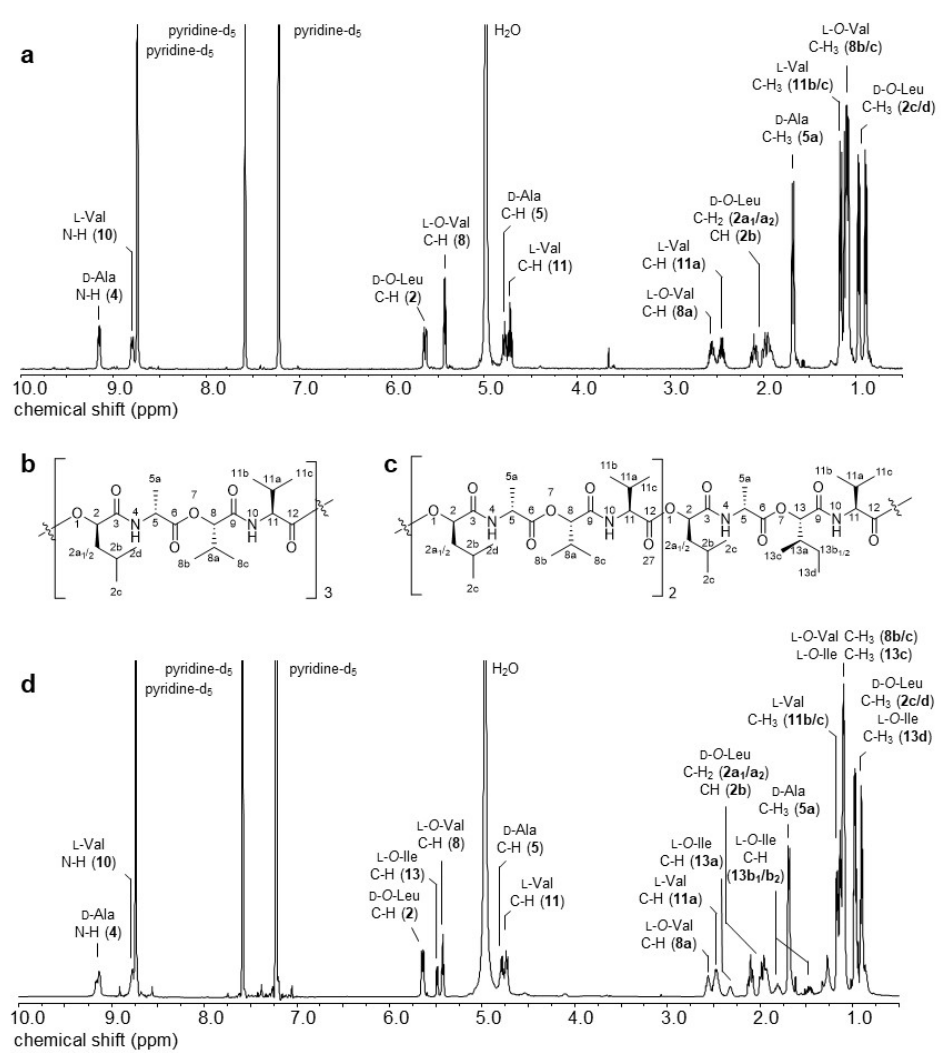
Figure 1. 1 H-NMR spectra and corresponding chemical structures of ( a , b ) cereulide ( 1 ) and ( c , d ) isocereulide A ( 2 ). From the further generated 1 H- 1 H-COSY-spectrum (Figure 2), the correlation of the single proton signals could be observed, giving, in combination with the signals integrals, the structures of the single amino acids Ala and Val ( × 3 each) and α -hydroxy acids O -Leu ( × 3) and O -Val ( × 2), but revealing one additional O -Ile moiety. This can be deducted from the correlation of the signals shown in Figure 2, with the key signal being the methine group 13a, exhibiting a correlation to the methyl protons 13c as well as to the methylene protons 13b 1 /b 2 . Those novel NMR experiments shed light on the assumption that in fact the isobaric α -hydroxy acid O -Ile is present in the chemical structure of 2 instead of the L - O -Leu moiety reported up to now [20].